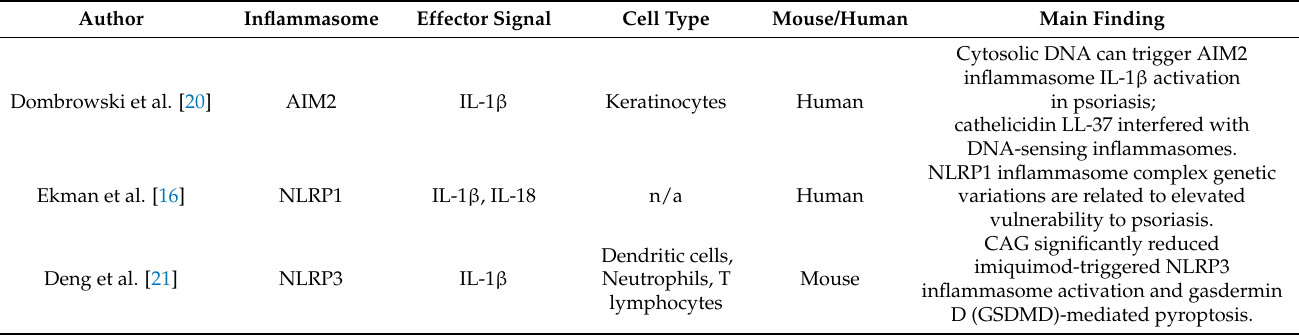
Table 1. The inflammasome in